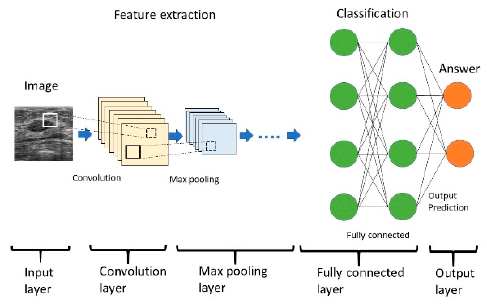
Figure 2. Structure of a convolutional neural network.